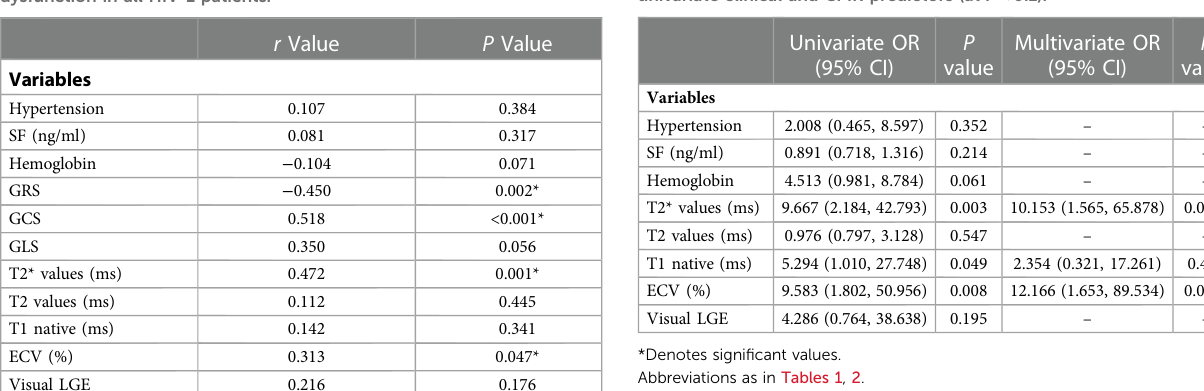
TABLE 3 Multivariable model of LV dysfunction with T2* adjusted to univariate clinical and CMR predictors (at P <0.1).